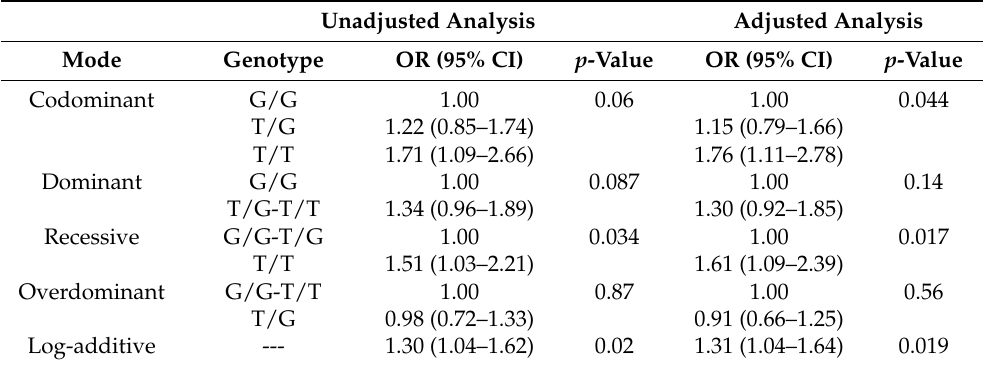
Table 2. Single locus analysis for association between ADORA2A rs5760423 and AD, in codominant, dominant, recessive, overdominant, and log-additive modes. Unadjusted Analysis Adjusted